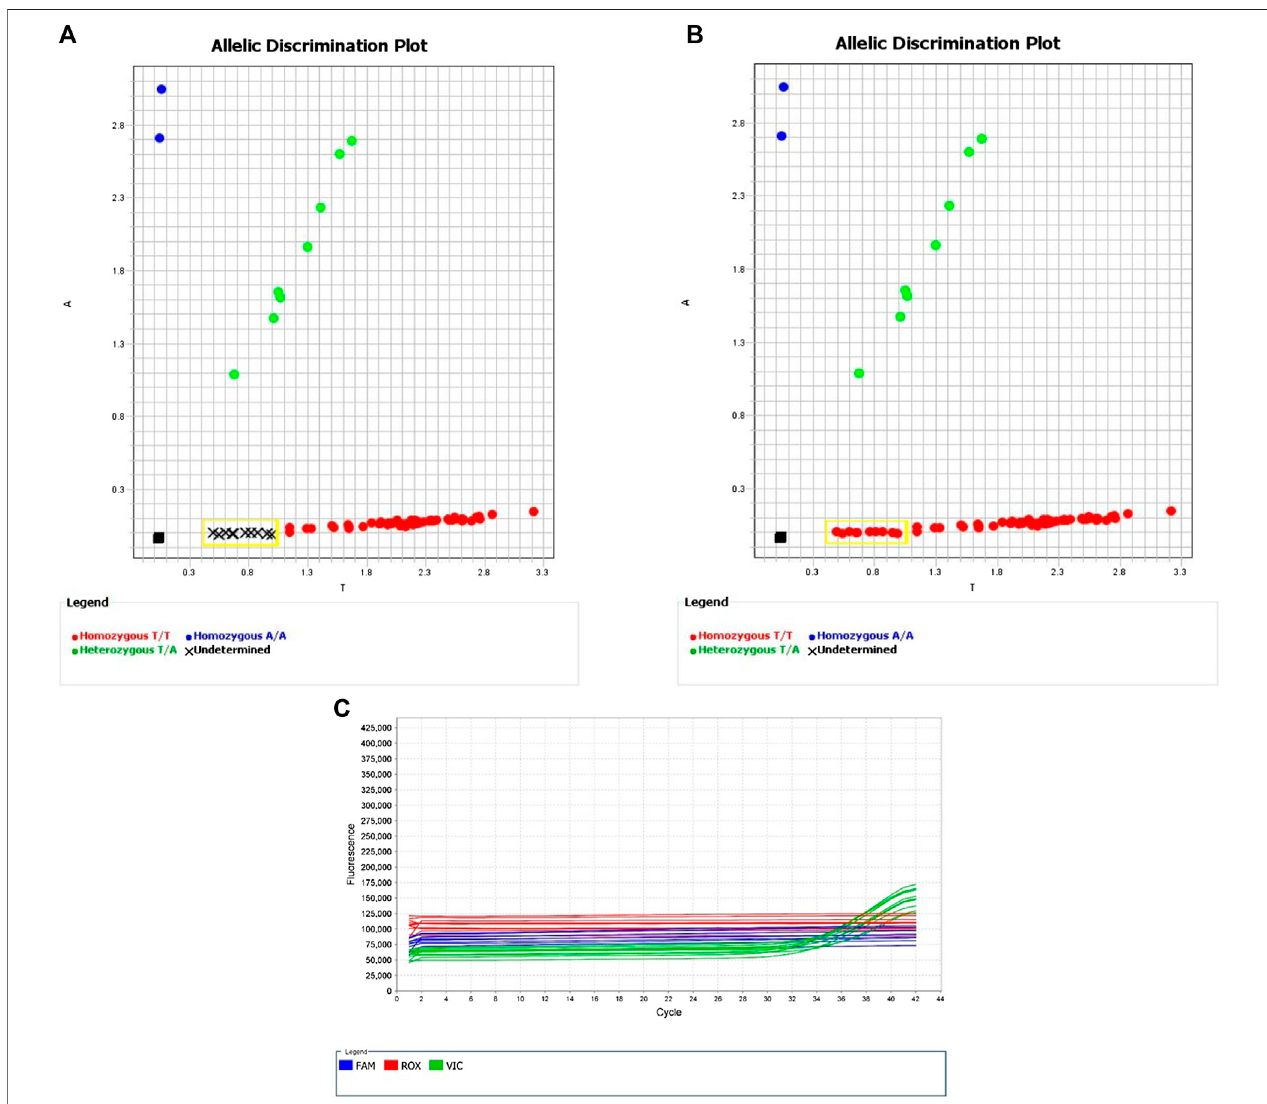
FIGURE 4 | Allelic Discrimination Plots and Multicomponent Plot for AN33GCK (rs144012689, rs2596496G)Black “ X ” s indicate samples for which the automatically generated calls failed. Samples in yellow box are the ones that showed the most signi fi cant ampli fi cation on assay AN2XMRN (NA17235, NA17256, NA18545, 689, 691, 755). (A) shows the software-generated calls, and (B) shows manually assigned calls based on relative fl uorescence. (C) Fluorescence of VIC dye on multicomponent plot for NA17235, NA17256, NA18545, 689, 691, 755 (samples in yellow box) indicates homozygous T/T call.